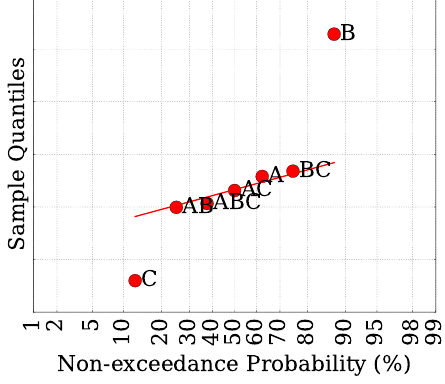
Figure 12: Adhesion